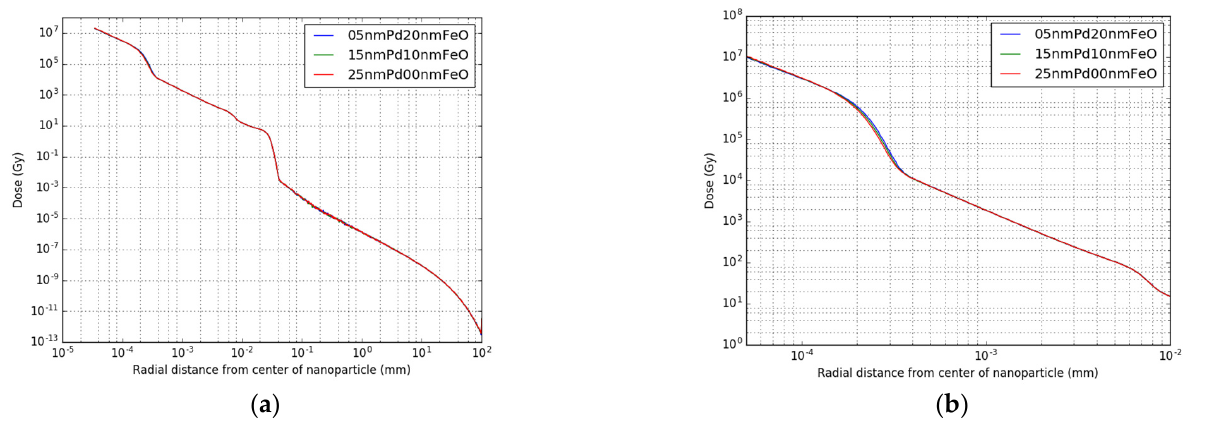
Figure 7. Radial radiation dose profile after 100,000 decays of: ( a ) the combined radiation of one nanoparticle with three core-shell topologies of 20, 10 and 0 iron oxide shell; and ( b ) a zoom-in of the dose profile around 1 × 10 − 4 mm distance.